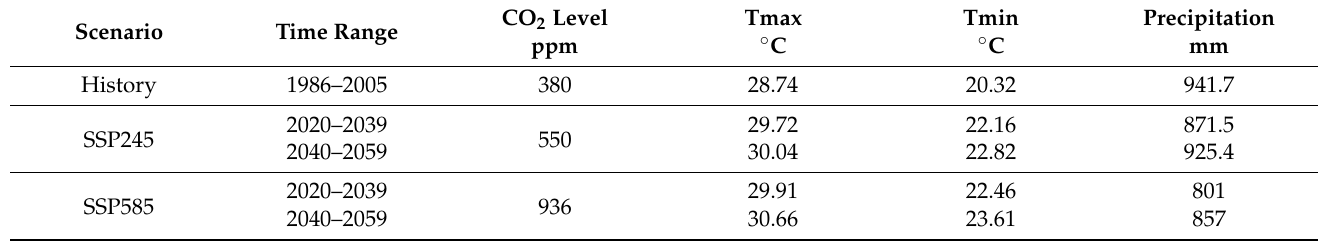
Table 8. Average CO 2 levels, maximum (Tmax) and minimum temperature (Tmin), and total precipitation in history period and future period under two climate change scenarios, SSP245 and SSP585, at study location in South Jeolla province, South Korea.